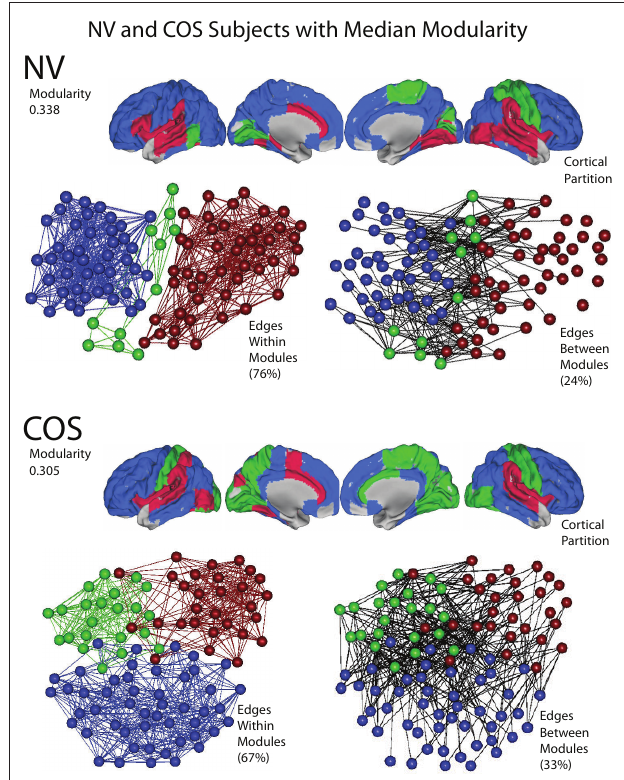
FIguRe 7 | An illustration of modularity, using representative brain networks from the childhood-onset schizophrenia (COS) population and the control (NV) population. At a local threshold of 0.22 topological cost, the modular partition is shown for the median NV subject (above) and the median COS subject (below), in terms of modularity estimated by the fast greedy algorithm. Each module is assigned a specific color, and the modular structure of each subject is illustrated in three different ways: the cortical partition shows the anatomical location of the modules; the left-hand topological plot shows the density of intra-modular edges, between nodes in the same module; and the right-hand topological plot shows the density of inter-modular edges, between nodes in different modules. The layouts of the topological plots are determined by a force-directed algorithm (Fruchterman and Reingold,